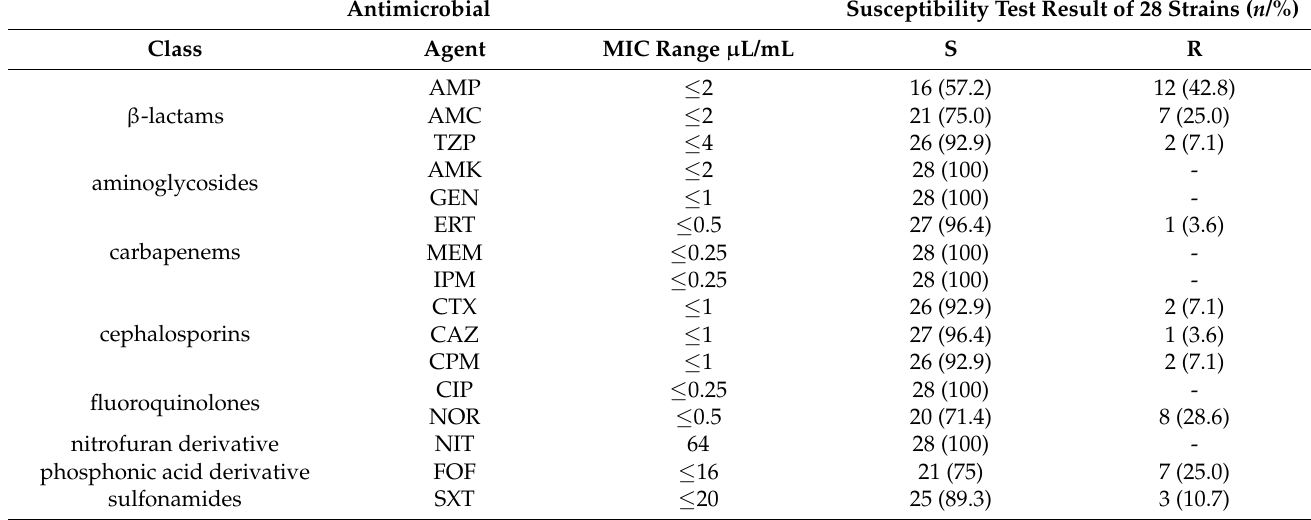
Table 2. Antimicrobial susceptibility profile of the Romanian fresh-cheese-origin E. coli strains tested with the AST-N204 card.